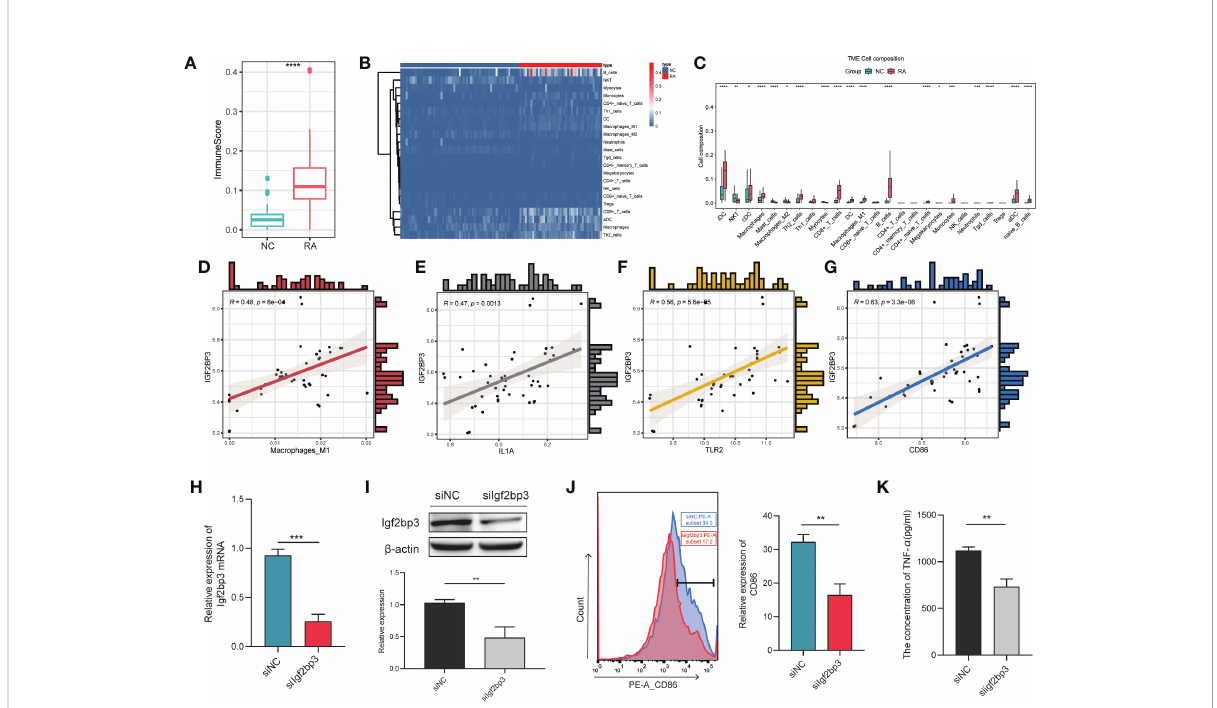
FIGURE 5 Correlation between IGF2BP3 expression and in fl ammatory activity. Immune scores (A) and proportions of immune cells (B, C) in the RA and NC groups; (D) correlation between the proportion of M1 macrophages and the expression level of IGF2BP3 in RA patients; (E – G) correlations between the expression levels of M1 macrophage markers (IL1A, CD86 and TLR2) and IGF2BP3; (H, I) RT − qPCR and Western blot analysis con fi rmed the ef fi ciency of gene silencing; (J) expression level of CD86 in RAW264.7 cells after transfection; (K) the content of TNF- a in RAW264.7 cells after transfection. * p < 0.05, ** p < 0.01, *** p < 0.001, **** p <